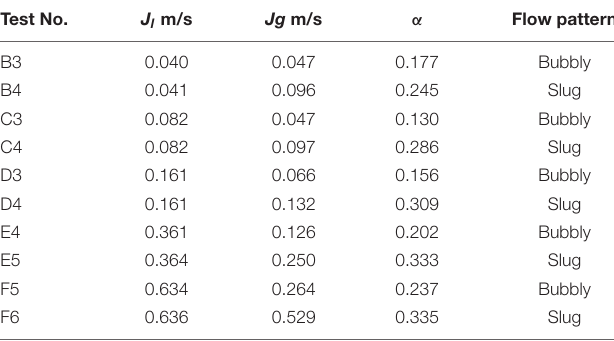
TABLE 2 | Void fraction experimental results. Test No.